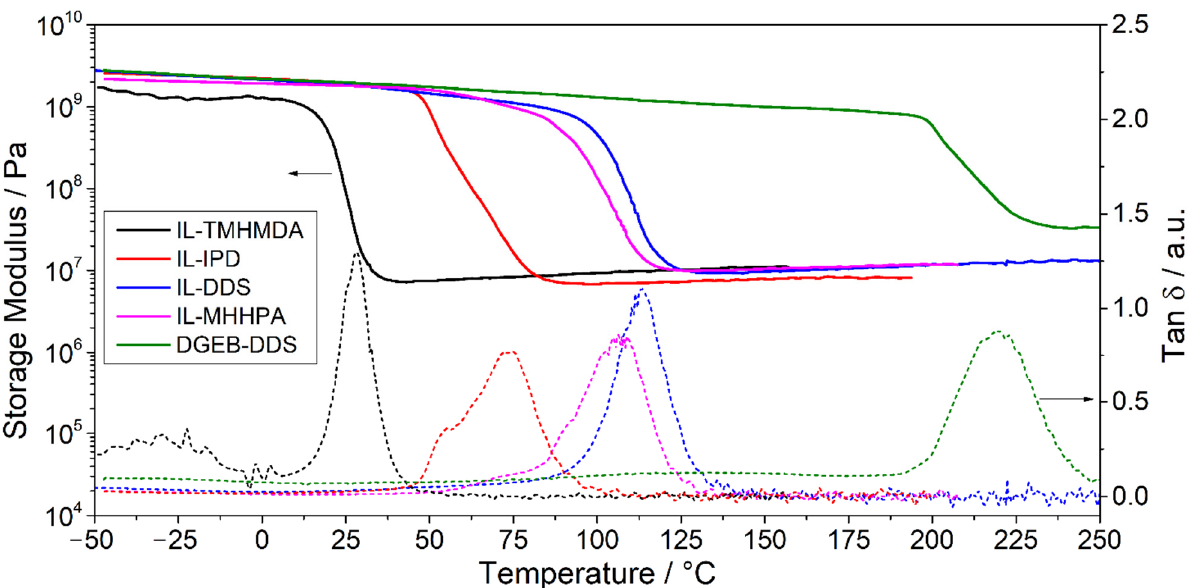
Figure 5. Storage modulus (solid lines) and tan δ (dashed lines) of the PIL networks and DGEB ‐ DDS. IL ‐ IPD and IL ‐ DDS exhibit storage moduli of 2.2 GPa and 2.1 GPa at 0 °C,